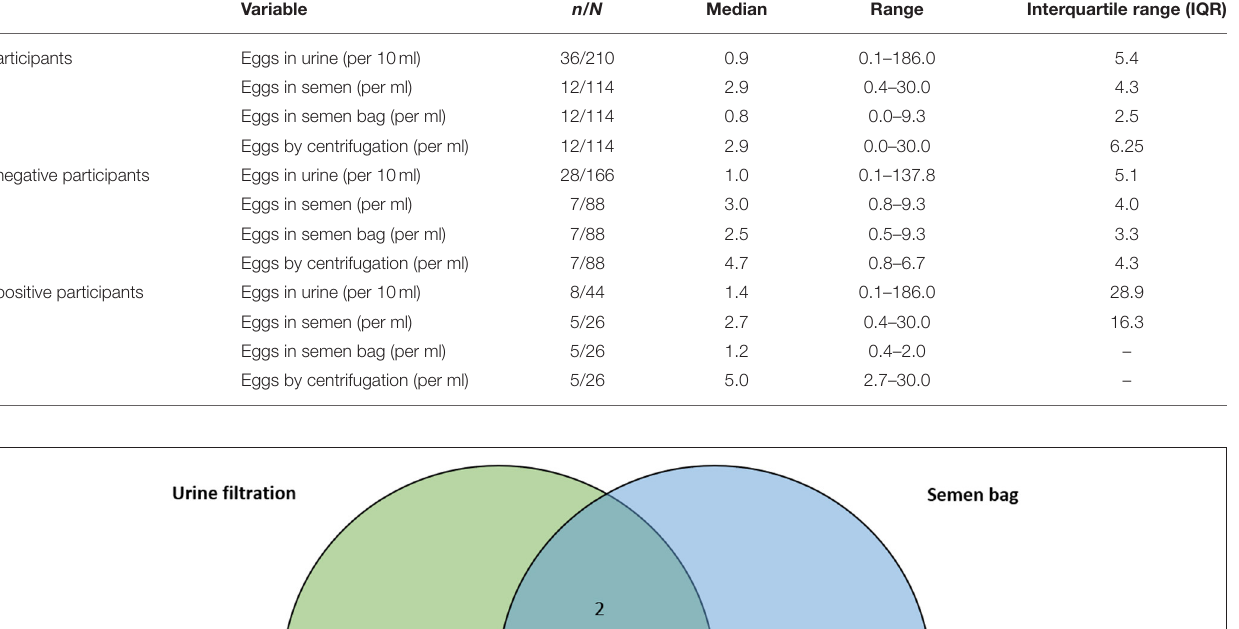
TABLE 4 | Parasitological analyses on urine and semen of the study participants. Variable n/N Median Range Interquartile range (IQR)